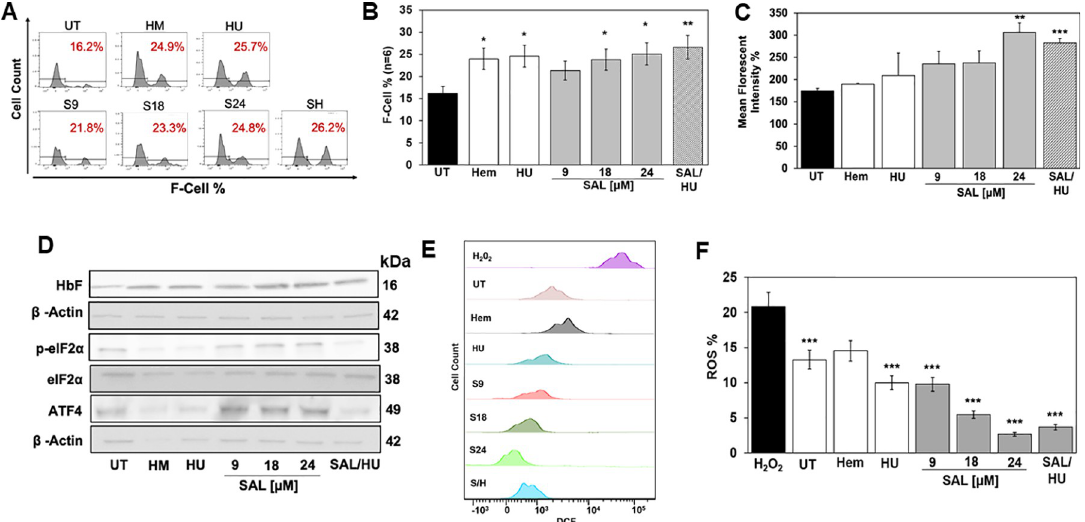
Fig 4. SAL activates HbF expression and reduces ROS levels in sickle erythroid progenitors. Sickle erythroid progenitors were grown in our two-phase culture systems and were treated on day 8 with Hem 75 μ M, HU 75 μ M and SAL 9, 18 and 24 μ M alone or SAL 18 μ M combined with HU 75 μ M. After 48 hours of treatment, data were generated and shown as the mean ± SEM (n = 6) and � p < 0.05; �� p < 0.01; ��� p < 0.001 was considered statistically significant. A) Shown is histograms representation of F-cell levels determined by flow cytometry. B) Shown is quantitative data generated by FlowJo analysis. C) The level of HbF expression was measured by MFI data generated by flow cytometry analysis. D) Representative western blots gel of HbF, p-eIF2 α and ATF4. E) Shown is a representative histogram overlay of DCF positive cell counts generated by flow cytometry as a measure of ROS levels; hydrogen peroxide (H 2 O 2 ) was used as a positive control. F) Shown in the bar graph is the quantitative data of ROS levels compared to untreated cells (UT).